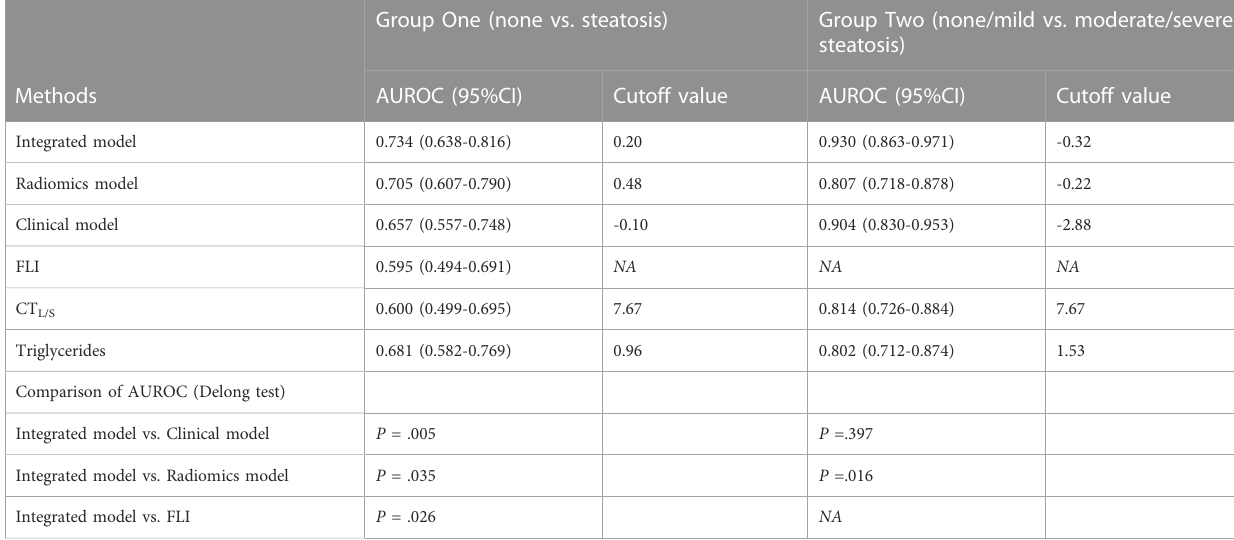
TABLE 3 Diagnostic performance of all methods for predicting liver cirrhosis in the validation cohort. Group One (none vs. steatosis) Group Two (none/mild vs. moderate/severe